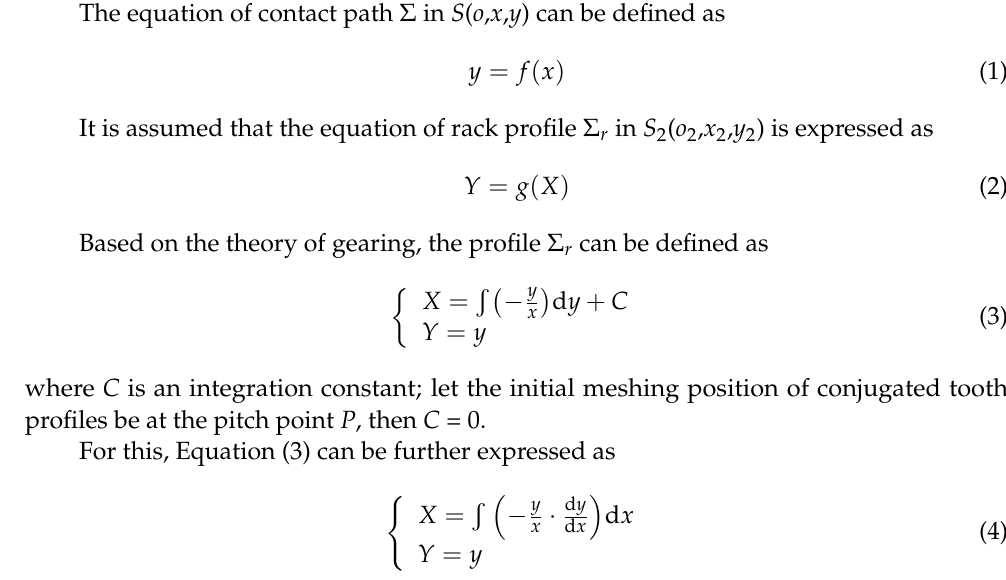
Figure 2. Generation of the shaper.